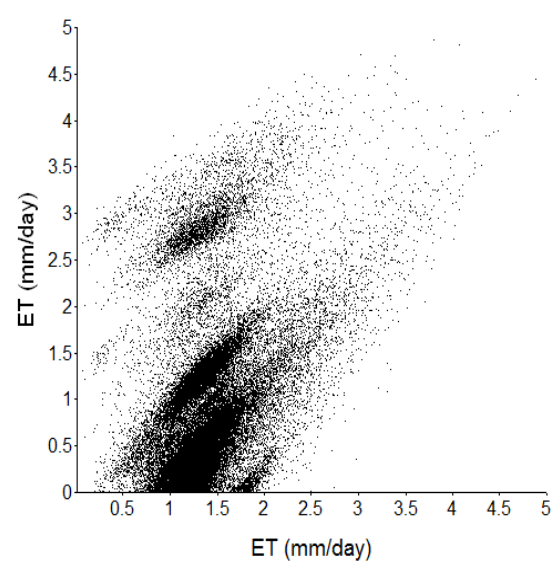
Figure 8. Scatterplot of ET single pixels values (mm/day) of corrected SEBAL (y) versus non-corrected SEBAL